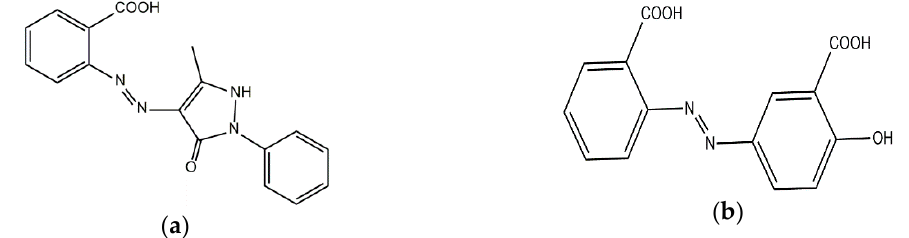
Figure 1. Chemical formulas of azo dyes: ( a ) Monocarboxylic azo dye (MCD); ( b ) dicarboxylic azo dye (DCD).